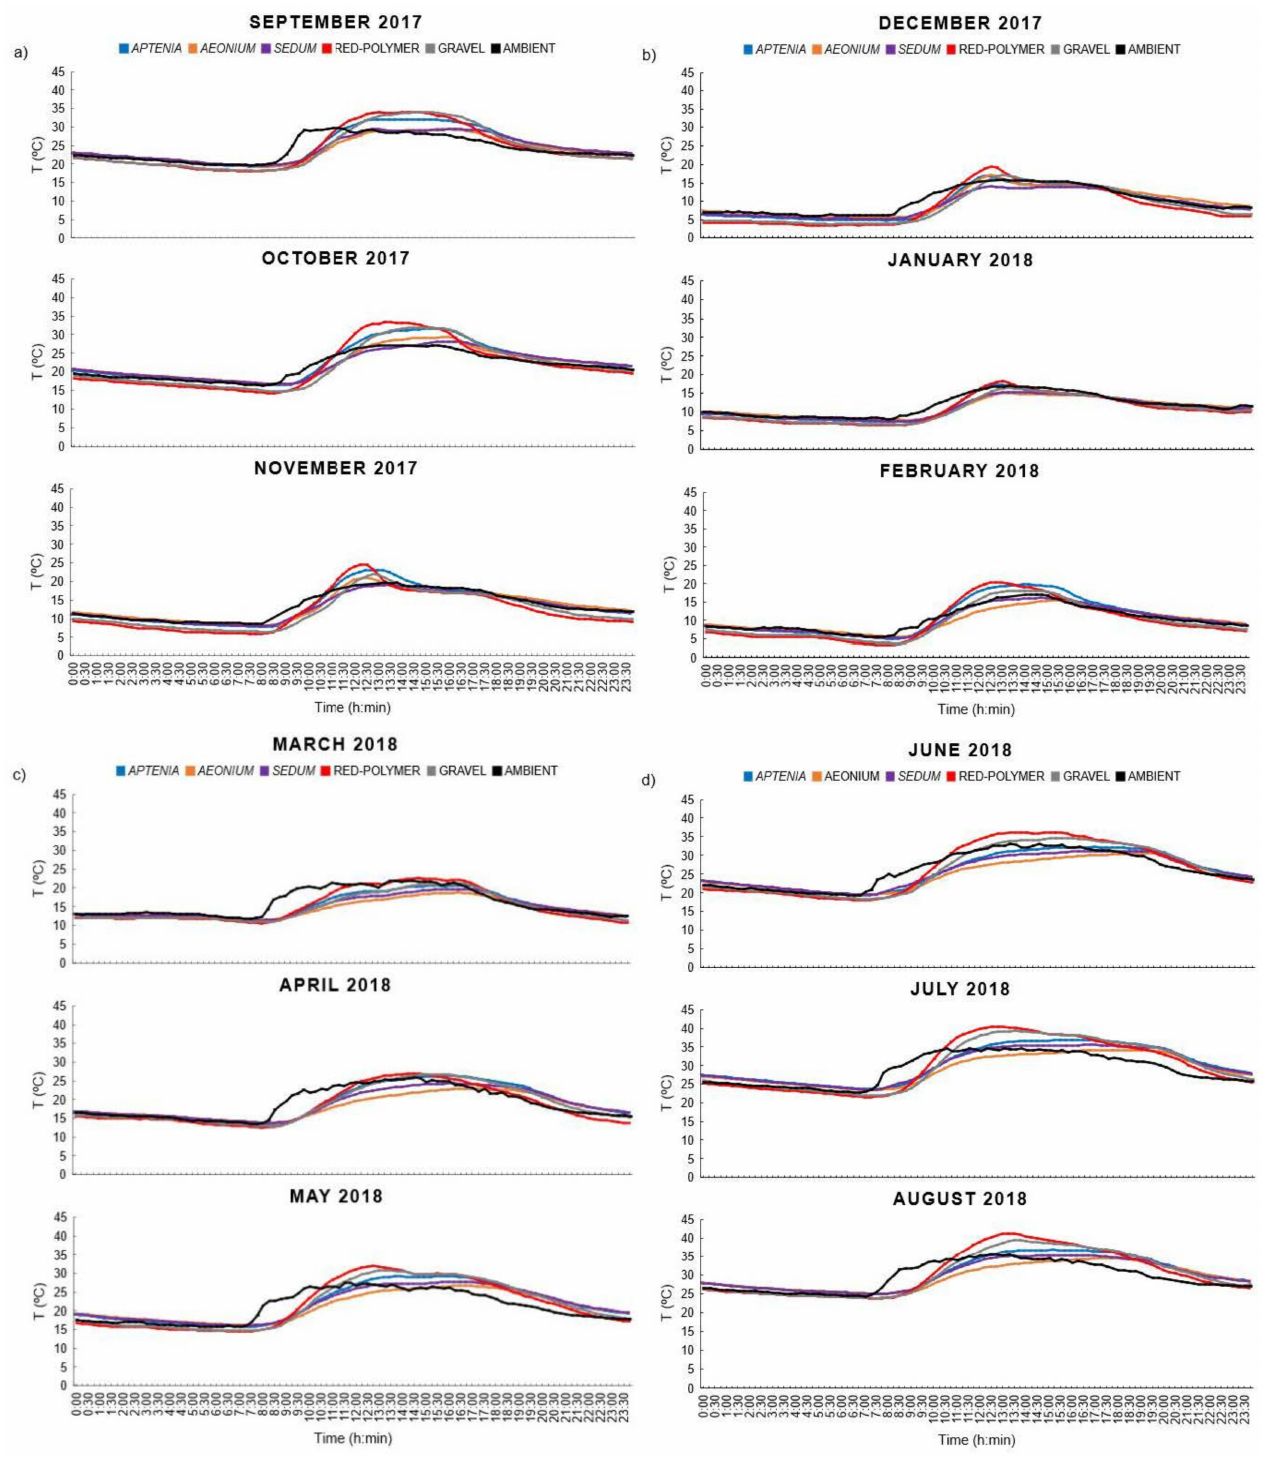
Figure 4. Average temperatures registered every 15 min during the day in the ambient, and under different covers: conventional (red-polymer, gravel) and green ( Aptenia , Aeonium and Sedum ) in ( a ) autumn 2017, ( b ) winter 2017–18, ( c ) spring 2018, and ( d ) summer